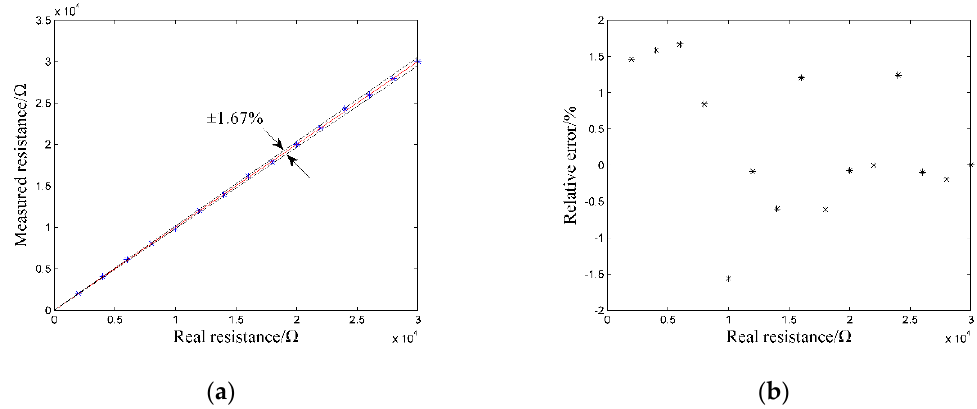
Figure 18. Results of resistance box experiment: ( a ) measured resistance; ( b ) relative errors.